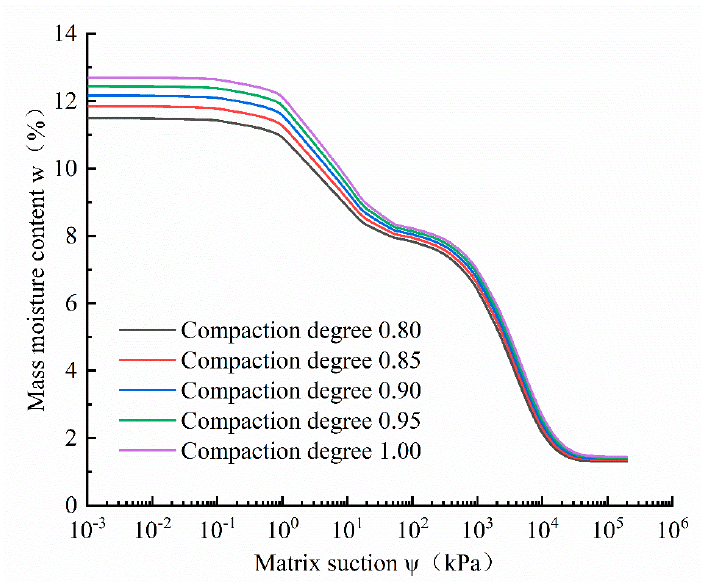
Figure 5. Soil–water characteristic curve.